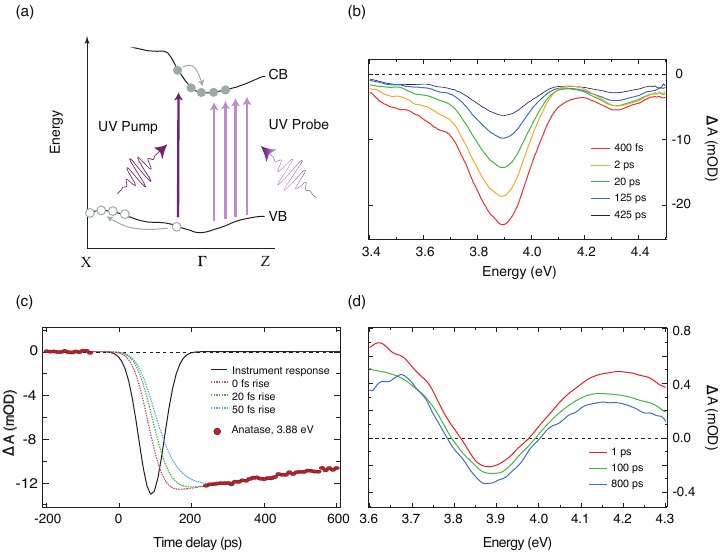
Fig. 1. (a) Schematic representation of the deep-UV based detection of the ultrafast carrier dynamics in anatase TiO 2 nanoparticles. The pump photon at 4.05 eV (purple arrow) excites electron-hole pairs through direct transitions. The broadband UV pulse (violet arrows) probes the exciton feature at 3.88 eV. The direct transitions contributing to this collective state lie along the G -Z region of the Brillouin zone. (b) Deep-UV pump/deep-UV probe experiment on a colloidal solution of bare anatase TiO 2 nanoparticles, excited at 4.05 eV with a fluence of 176 µ J/cm 2 . The D A spectra are shown as a function of probe photon energy at representative delay times between pump and probe. (c) Evaluation of the rise-time of the D A signal by interpolating the response of anatase TiO 2 using a rising function (convoluted with a Gaussian instrument response function of 80 fs) at three different times. (d) Visible pump/deep-UV probe experiment on a colloidal solution of N719 dye-sensitized anatase TiO 2 nanoparticles, excited at 2.25 eV with a fluence of 168 µ J/cm 2 . Above-gap excitation at 4.05 eV of a colloidal solution of nanoparticles creates uncorrelated electron-hole pairs, and results in the transient absorption ( D A) spectra of Fig. 1(b). The long-lived feature at 3.88 eV corresponds to the a-axis exciton band, while